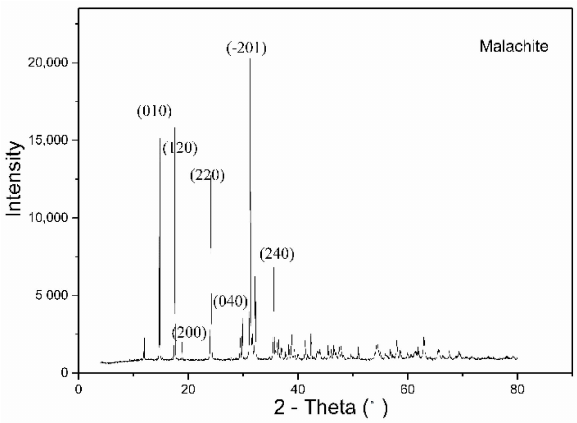
Figure 1. X-ray diffraction (XRD) pattern of the malachite